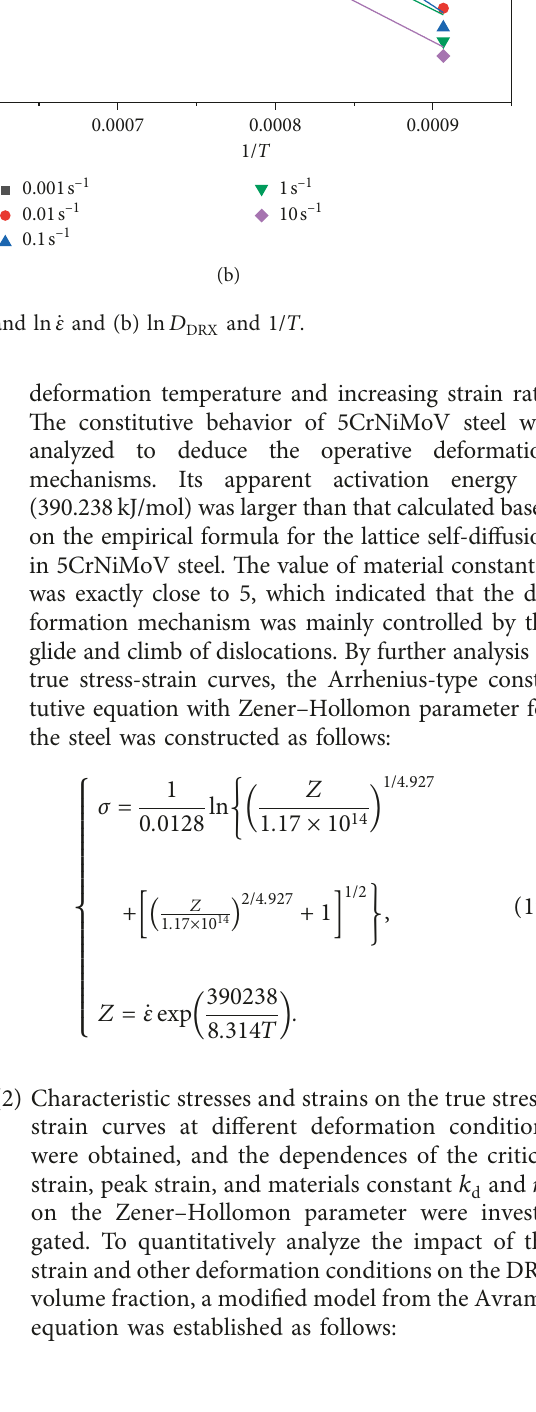
and ln _ ε and (b) ln D DRX